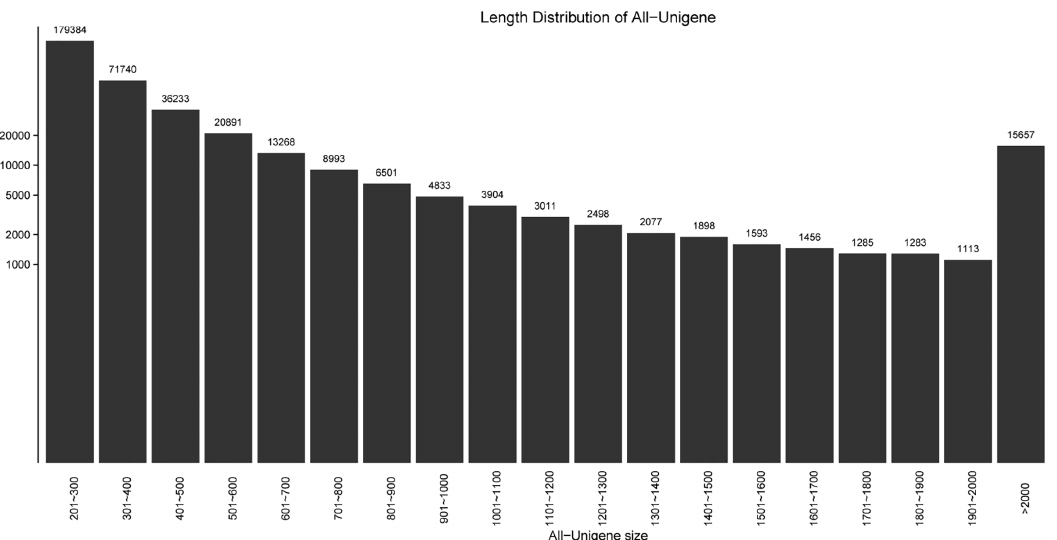
Fig 1. Length Distribution of all unigenes. The x-axis indicates sequence sizes from 200 nt to (cid:1) 2000 nt; the y-axis indicates the number of unigenes for a given sequence